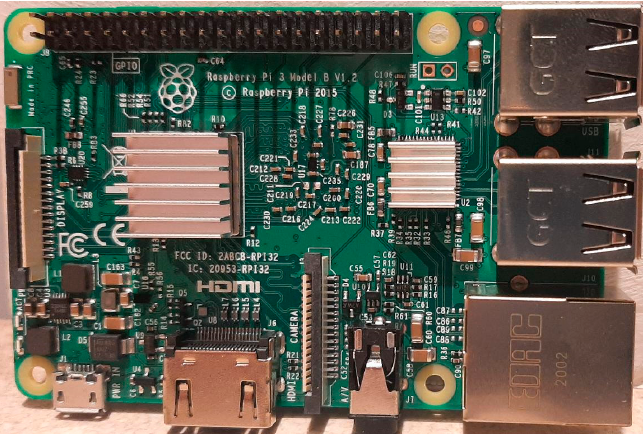
Figure 7. A photograph of Raspberry PI B solution used in the machine.